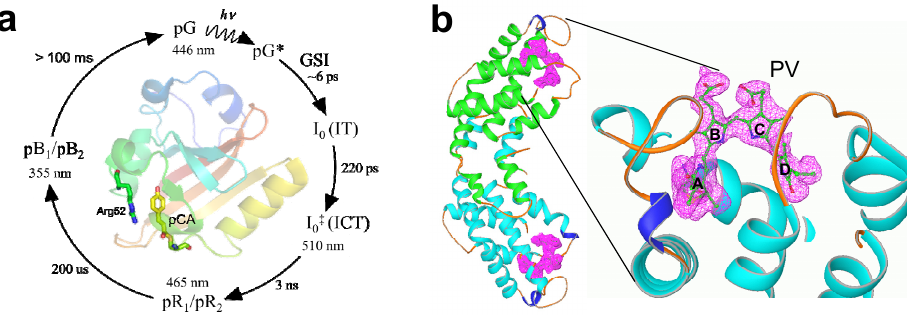
Figure 1. ( a ) PYP photocycle. pG: dark state; pG*: electronically excited state; GSI: fs intermediate [39]; I and I 0‡ : ps intermediates [40], may be equivalent to IT and ICT 0 structures [41]; pR and pB: red and blue shifted species, respectively [36]. Structure of PYP is displayed in the center, chromophore (pCA) and Arg52 marked. Structures of pG, IT, ICT, pR /pR , pB /pB are available from protein data bank (pdb) [42] entries 2PHY, 1 2 1 2 3VE3, 3VE4, 1TS7 and 1TS0/1TS6, respectively; ( b ) Dimeric (blue and green) structure of α -PEC in its E- form (pdb-entry 2J96, Z-form, pdb-entry 2C7L, not shown);